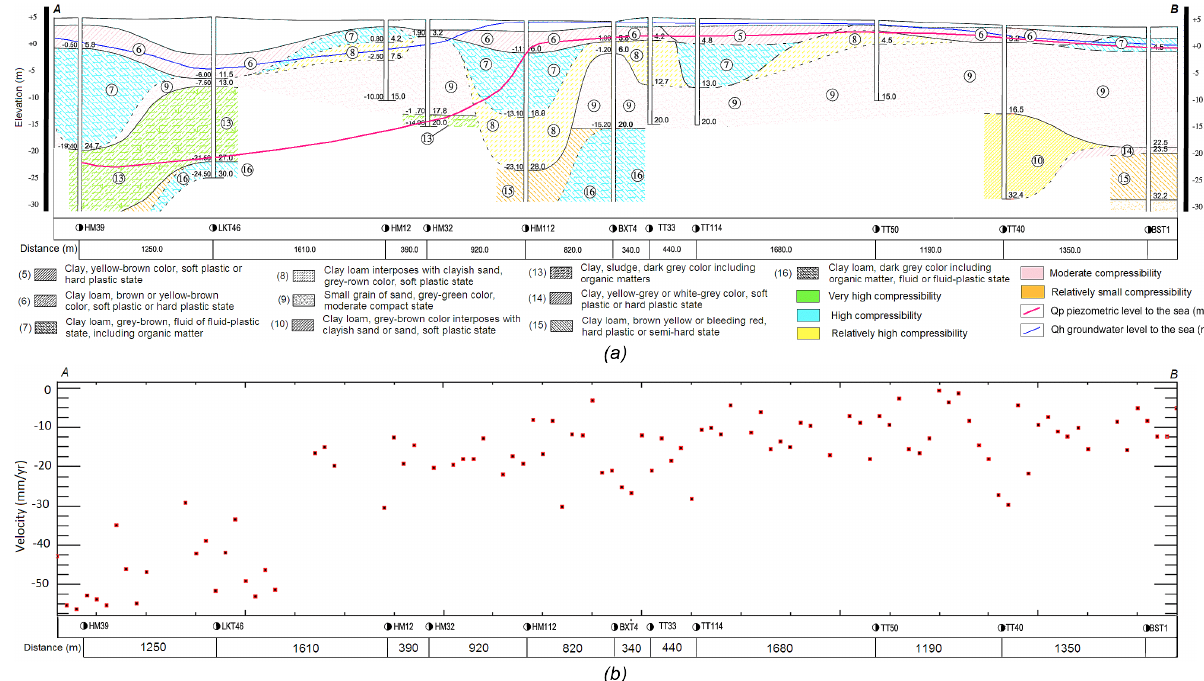
Fig. 8. (a) Geologic profile AB of first subsidence area, (modified from Nguyen, 2005), groundwater level in Q h aquifer (blue), (after Vietnam Institute of Geosciences and Mineral Resources, 2010), and piezometric level of Q p aquifer (red), (after the Northern Division of Planning and Investigation for Water Resources, 2010). For spatial pattern of isocontours, refer to Fig. 11. (b) Graph of InSAR vertical velocity following the profiles AB. For location of profile AB, refer to Fig. 7 or Fig. 11.